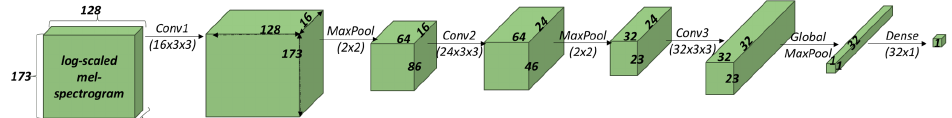
Figure 9. Overall architecture of developed Deep CNN for bark detection task. Input tensor is log-scaled mel-spectrogram, with 173 rows, each one of them containing 128 values (mels) and one channel. Every convolutional operation is followed by a ReLU activation function, and pooling layers are followed by a dropout equal to 0.5. Final dense layer outputs one value and is followed by a sigmoid operation that represents probability of SaR dog barking or not